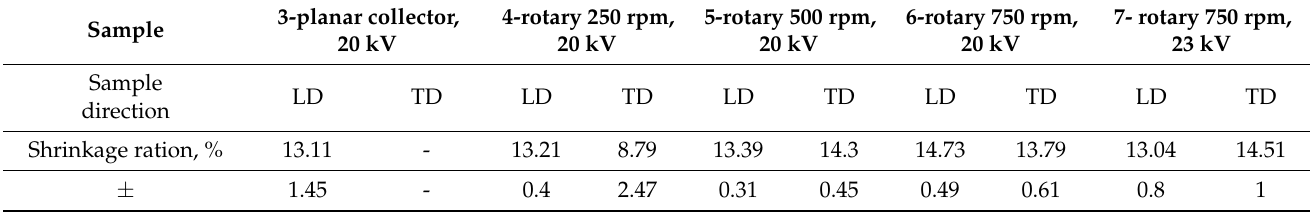
Table 4. The shrinkage ratio of samples